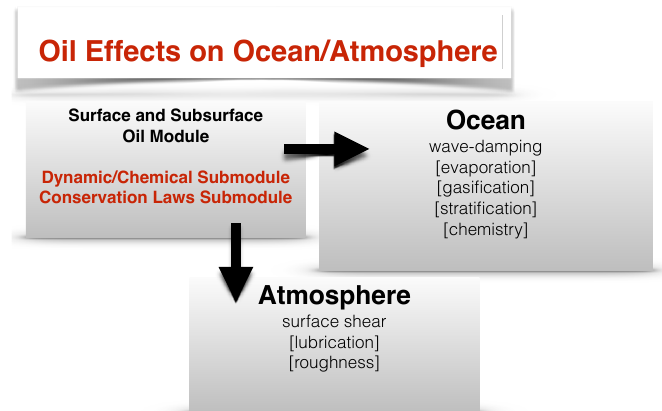
Figure 3. Effects of oil on the atmosphere and the ocean that will be included in the model development. See Figures 1 and